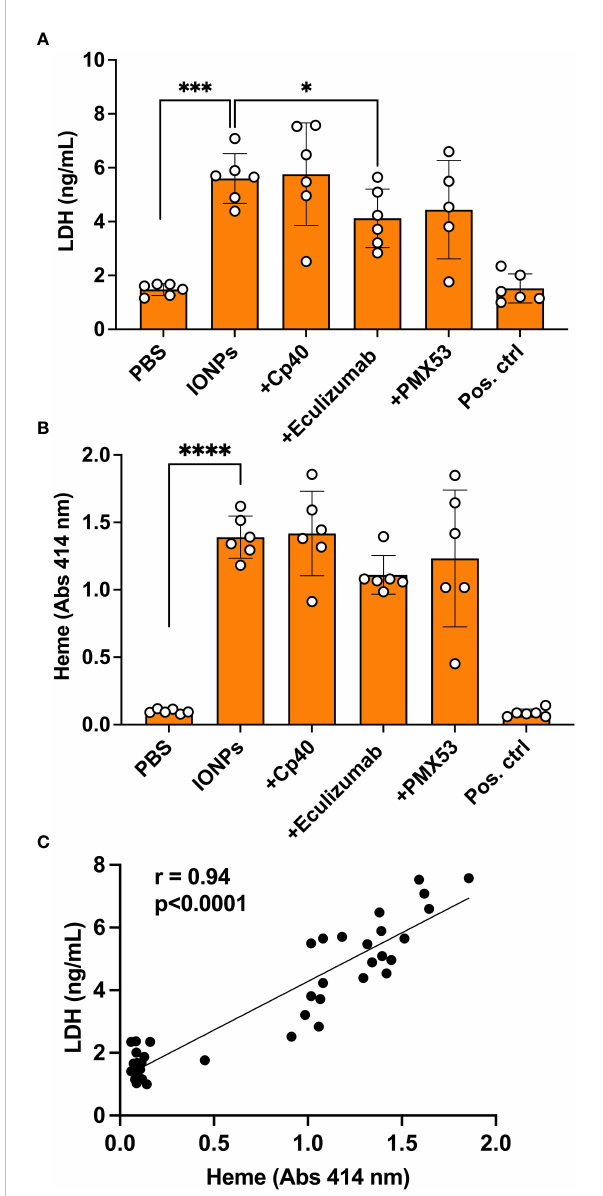
FIGURE 5 IONPs-induced cytotoxic effect. Human whole blood was incubated together with HLMECs and a mixture of IONPs (100 m g/mL) of different sizes; 10, 20, and 30 nm in the presence of inhibitors; Cp40 (20 m M), eculizumab (100 m g/mL) or PMX53 (10 m g/mL) for four hours at 37 °C. Zymosan (100 m g/mL) and LPS (10 ng/mL) in combination served as a positive control (Pos. ctrl) and PBS as a negative control (PBS). Cytotoxicity was evaluated in plasma by measuring LDH concentration by ELISA (A) and heme (B) by absorbance spectroscopy at 414 nm. The correlation between LDH and heme is shown (C) . The values are presented as mean +/- standard deviation of n=6. *p<0.05, ***p<0.001, ****